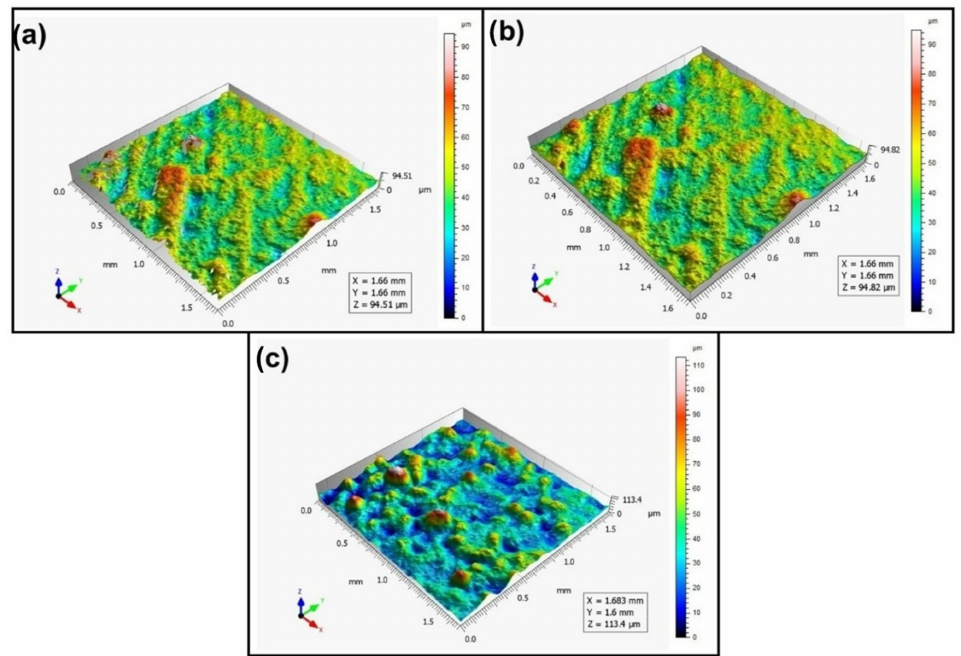
Figure 13. Surface topography of the element 3D printed using SLM technology (Pd = 45 ◦ ). ( a ) Taly- surf CCI—without filling non-measured points, ( b ) Talysurf CCI—after filling non-measured points, ( c ) Talysurf PGI